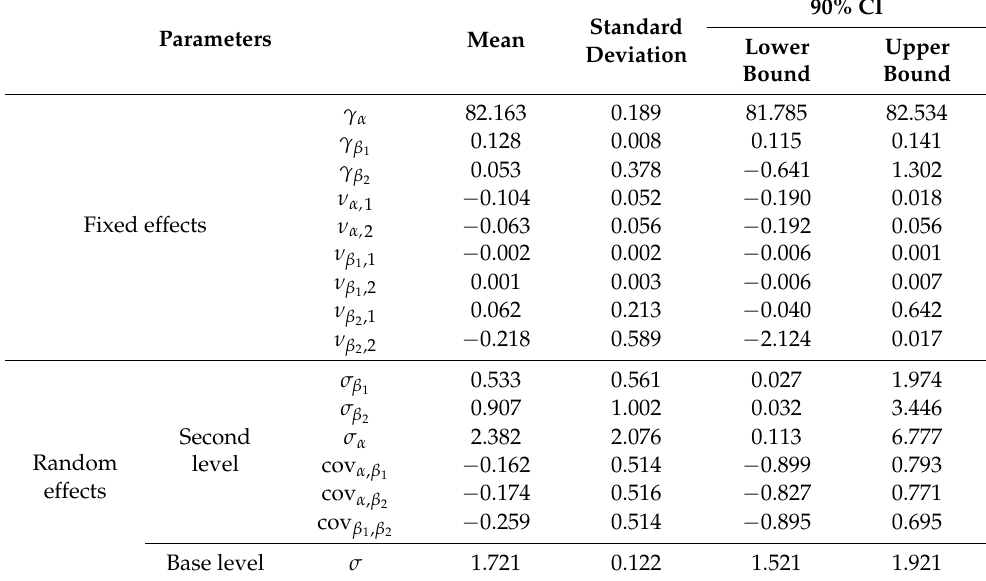
Figure 6. (Color Online) The residual between the regression function and destructive data of traditional Bayesian regression model from the first week only. Table 2. The posterior distribution of hierarchical model parameters (without